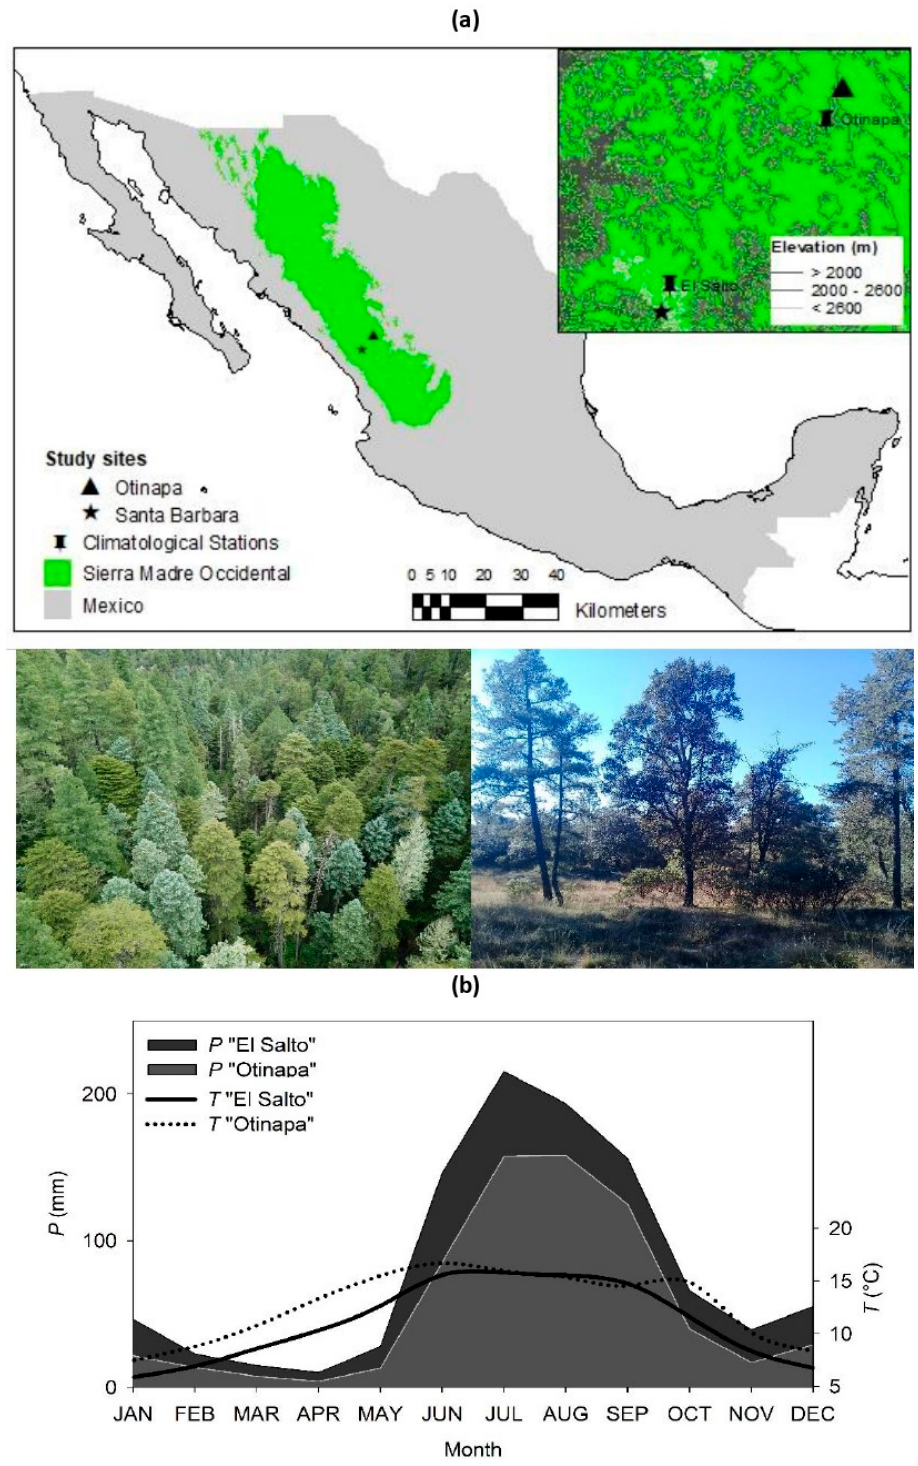
Figure 1. Location of the study sites in northern Mexico, in the state of Durango, with photographs of the ecosystems studied ( a ) and local climatograms of the weather stations “El Salto” and “Otinapa” ( b ); the diagrams show the monthly distribution of precipitation (P) and temperature (T).